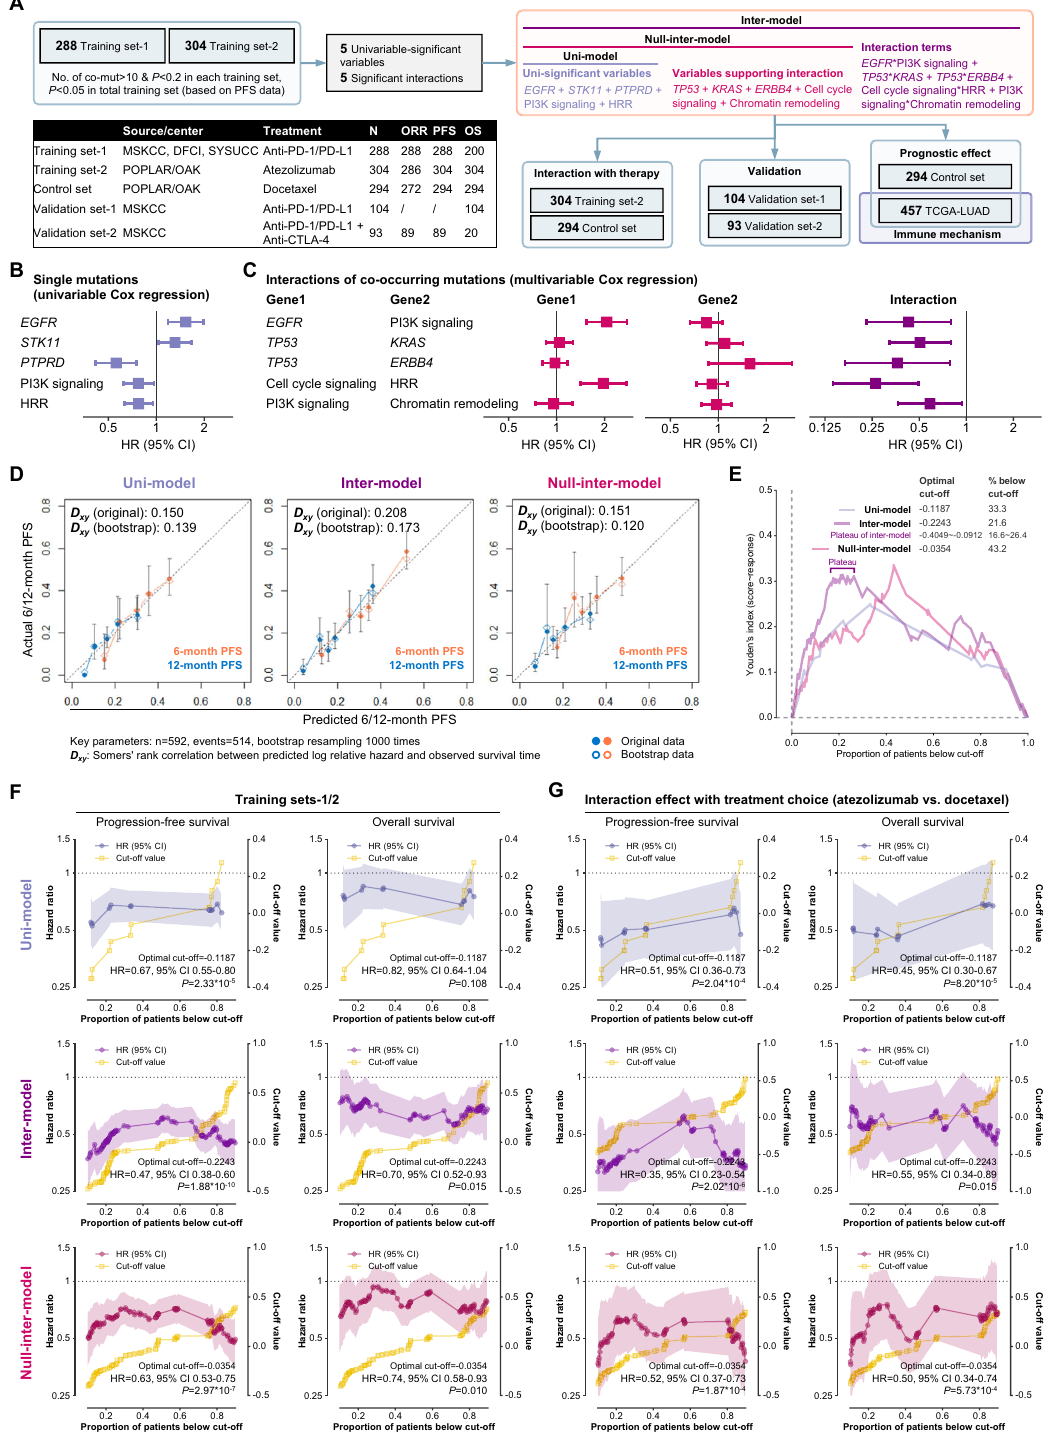
Fig. 2 Performances of the three models in the training sets of nonsquamous NSCLC. A Work fl ow of developing and validating three models in nonsquamous NSCLC. B , C The single mutations ( B ) and interaction effects of co-mutations ( C ) selected for model development. D Calibration curves of the three models in the training sets-1/2. E Youden ’ s index based on the receiver operating characteristic curve of the three inter-scores and response to anti-PD-(L)1 monotherapy in the training sets-1/2. F Performances of the three models on discriminating the PFS and OS on anti-PD-(L)1 monotherapy in the training sets-1/2. G Performances of the three models on predicting the PFS and OS bene fi t from atezolizumab over docetaxel in the POPLAR/OAK cohort. Abbreviations: DFCI Dana Farber Cancer Institute, MSKCC